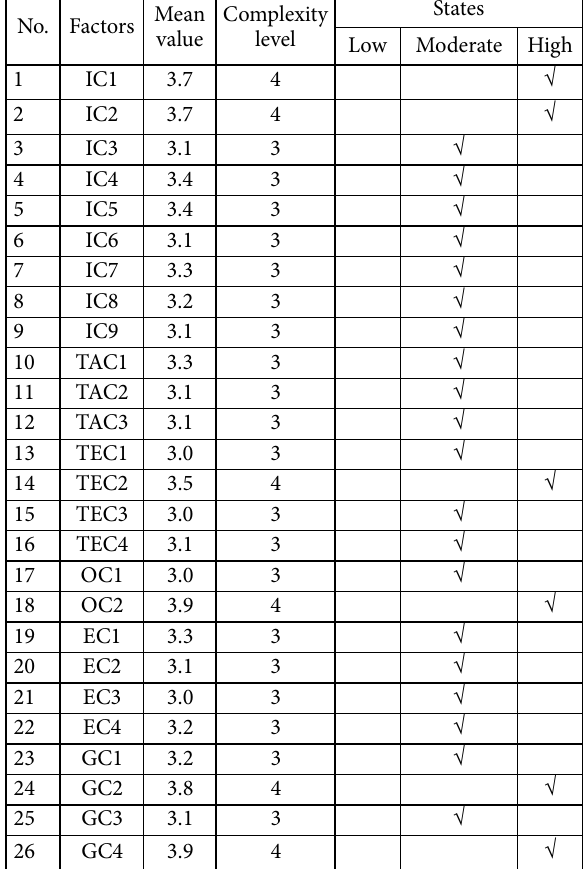
Table 5. Complexity variables information of the EXPO